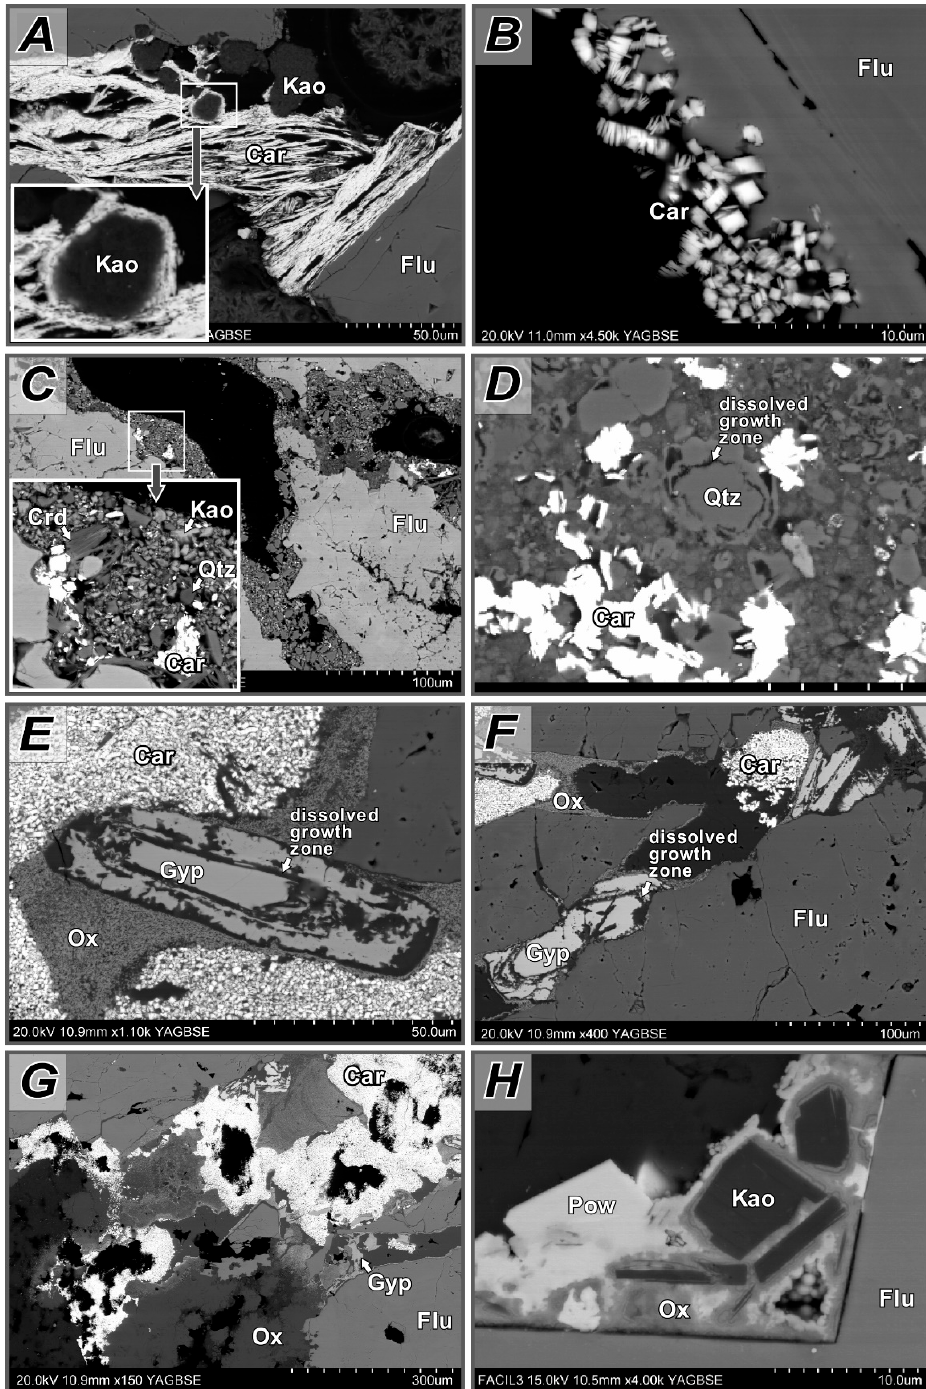
Figure 6. Back-sacattered electron images of mineral associations in the fluorite–U–V–Mo–P stringers in the Aguachile area, Coahuila. ( A ) Kaolinite “lumps” enveloped by carnotite crystals in fractures in MVT-like fluorite. ( B ) Carnotite crystal aggregates intergrown with fluorite in the early parageneses. ( C ) Association that consists of carnotite, crandallite, kaolinite and quartz. ( D ) Quartz with dissolved growth zones in association with carnotite. ( E and F ) Early carnotite and late iron oxihydroxides with partially dissolved gypsum. ( G ) General aspect of stringers with early carnotite and late iron oxihydroxides. ( H ) Late mineralisation with kaolinite, iron oxihydroxides and powellite on fluorite. Key: Car = carnotite, Crd = crandallite, Flu = fluorite, Gyp = gypsum, Kao = kaolinite, Ox = iron oxihydroxides, Pow = powellite, Qtz = quartz.